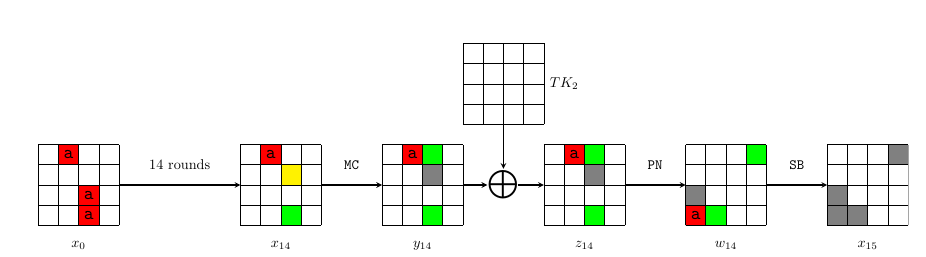
Figure 6: A 15-round truncated differential trail of CRAFT with probability 2 − 54 , where the differences marked by green cells must be of the same value, the difference of the yellow cell can be any value, and x figure.